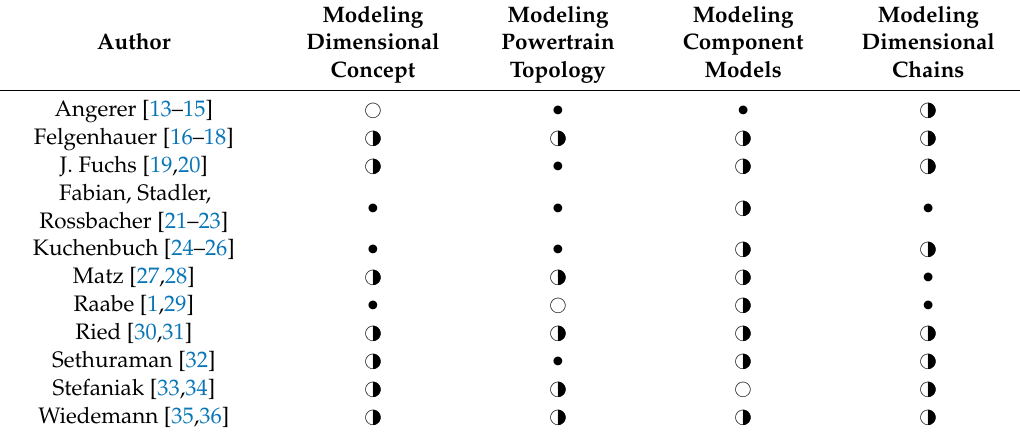
Table 1. Overview of the authors who model at least three features of the BEV